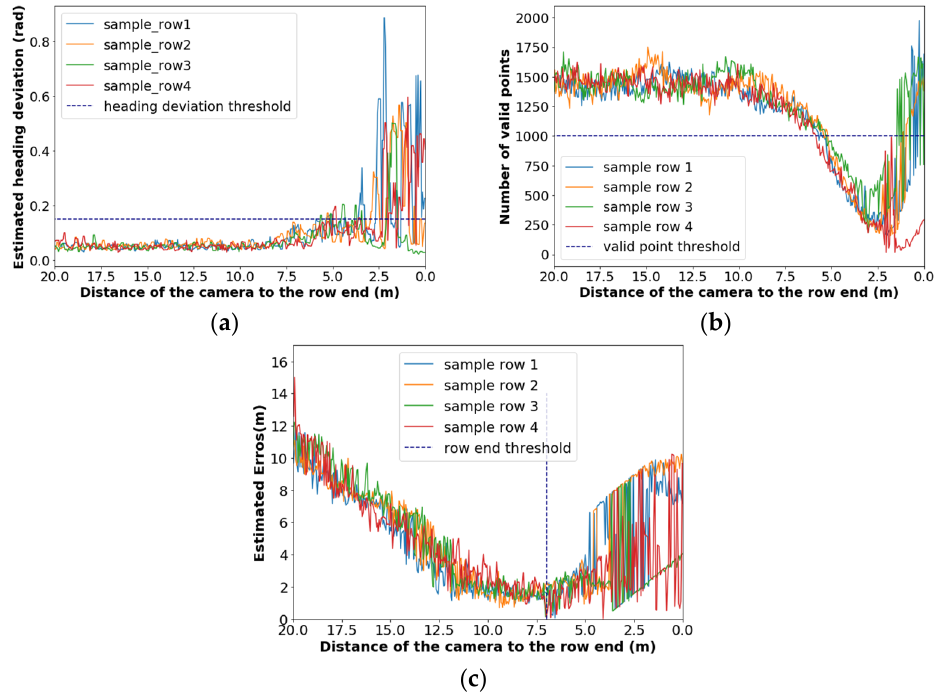
Figure 12. ( a ) Estimated heading deviation; ( b ) number of valid measurements; and ( c ) row end distance estimation. In all figures, the horizontal axis is the actual distance of the robot to the end of the row.